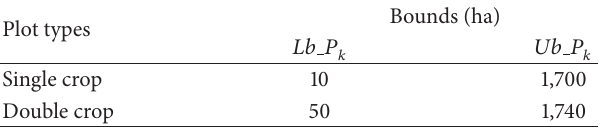
Bounds (ha) 𝐿𝑏 𝑃 𝑈𝑏 𝑃 𝑘 𝑘